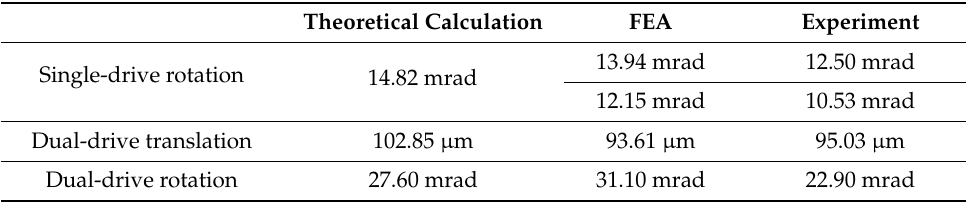
Table 5. Comparison of theoretical, simulation, and experimental